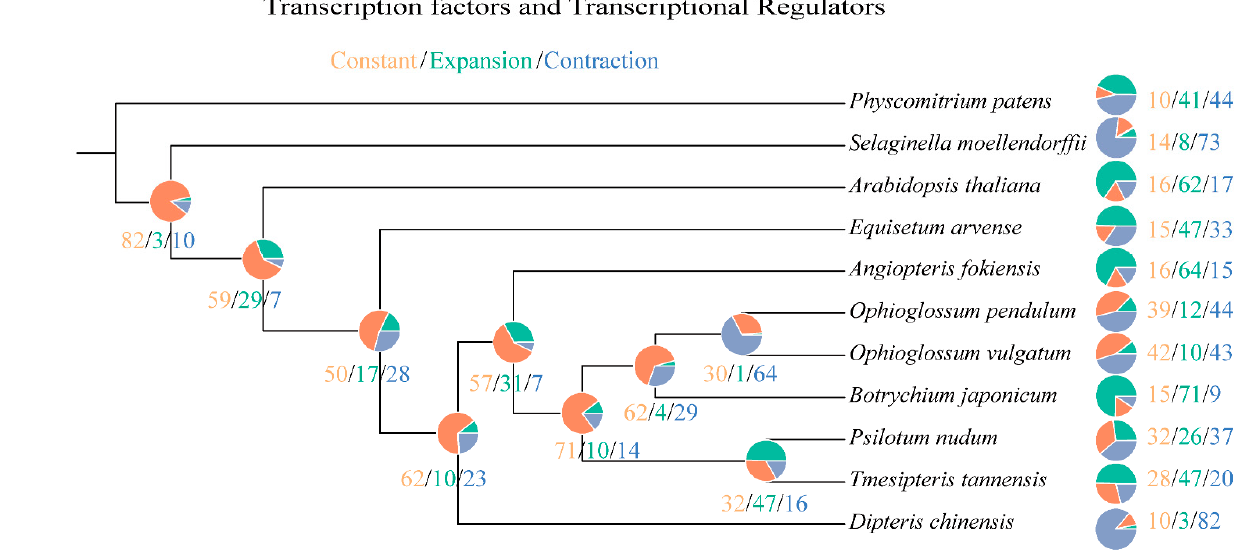
Figure 3. Phylogenetic tree showing the evolution of TF/TR gene family sizes in 11 plant species. The whisk fern clade consisting of Psilotum nudum and Tmesipteris tannensis is clustered with the ophioglossoid fern clade consisting of Ophioglossum pendulum , O. vulgatum and Botrychium japonicum . Table 1. A summary of rapidly evolved TF/TR families identified by CAFÉ. Species